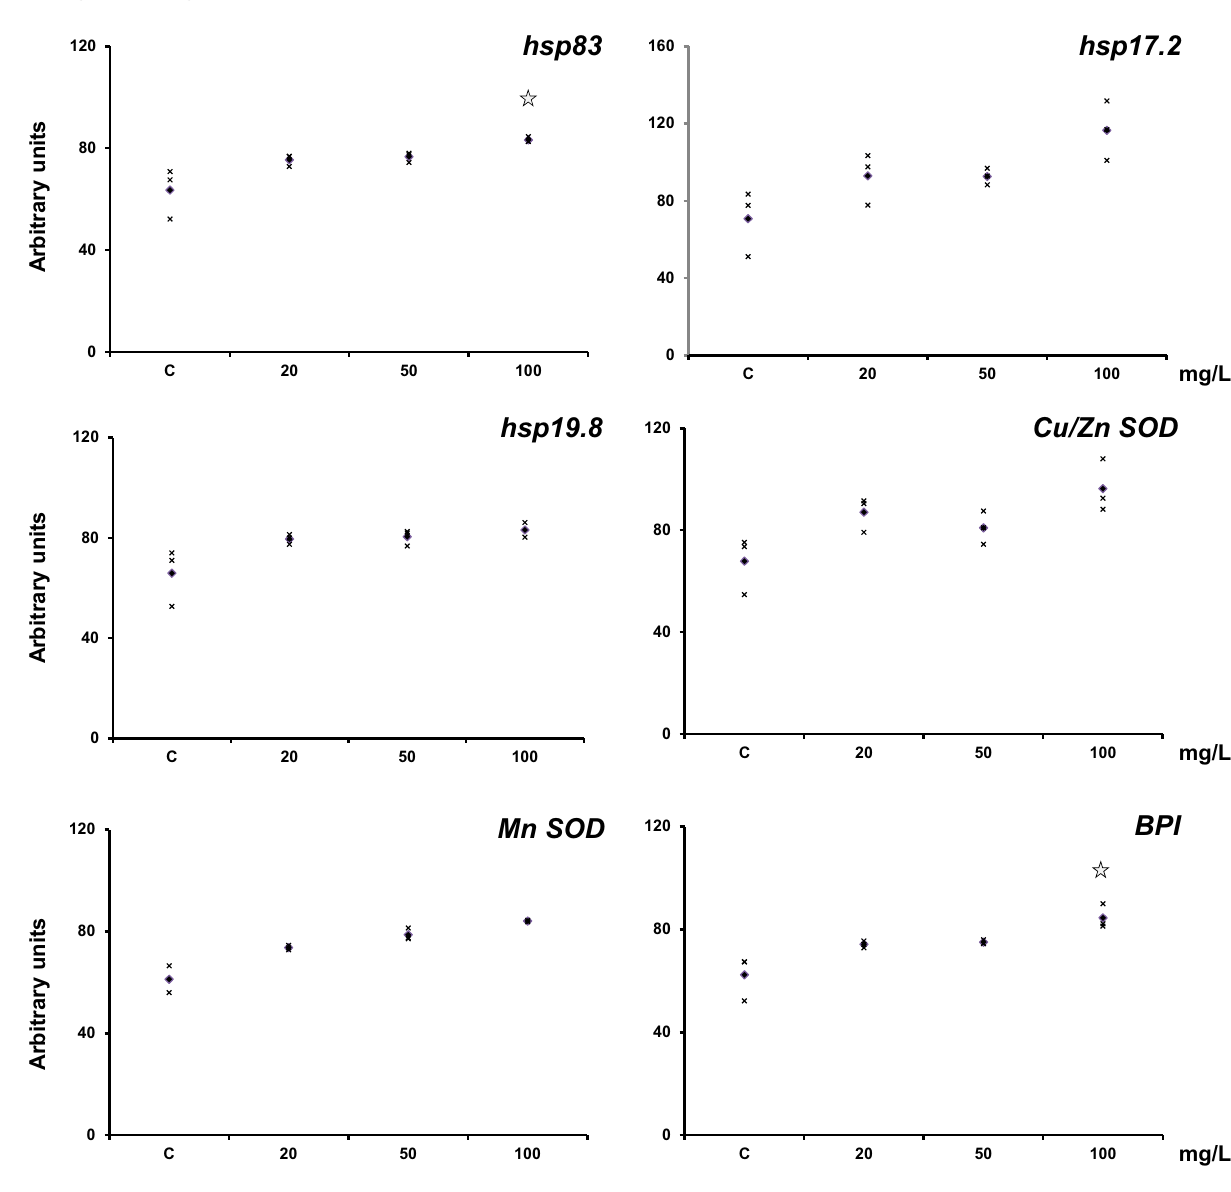
Figure 3. Transcriptional activity of hsp83 , hsp17.2 , hsp19.8 , Cu–Zn SOD , Mn-SOD , and BPI in the digestive gland of adult H. aspersa. Animals were exposed to Ag-NPs at (20 ± 2 °C) for 7 days by feeding them with lettuce soaked in silver nanoparticles. Levels of mRNA were normalized using GAPDH as a reference gene. Three experiments were carried out, and the data are shown for each experiment (x). The diamond indicates the mean. The star indicates statistically significant differences against control animals ( p < 0.05). The figure was drawn with Excel (Microsoft,